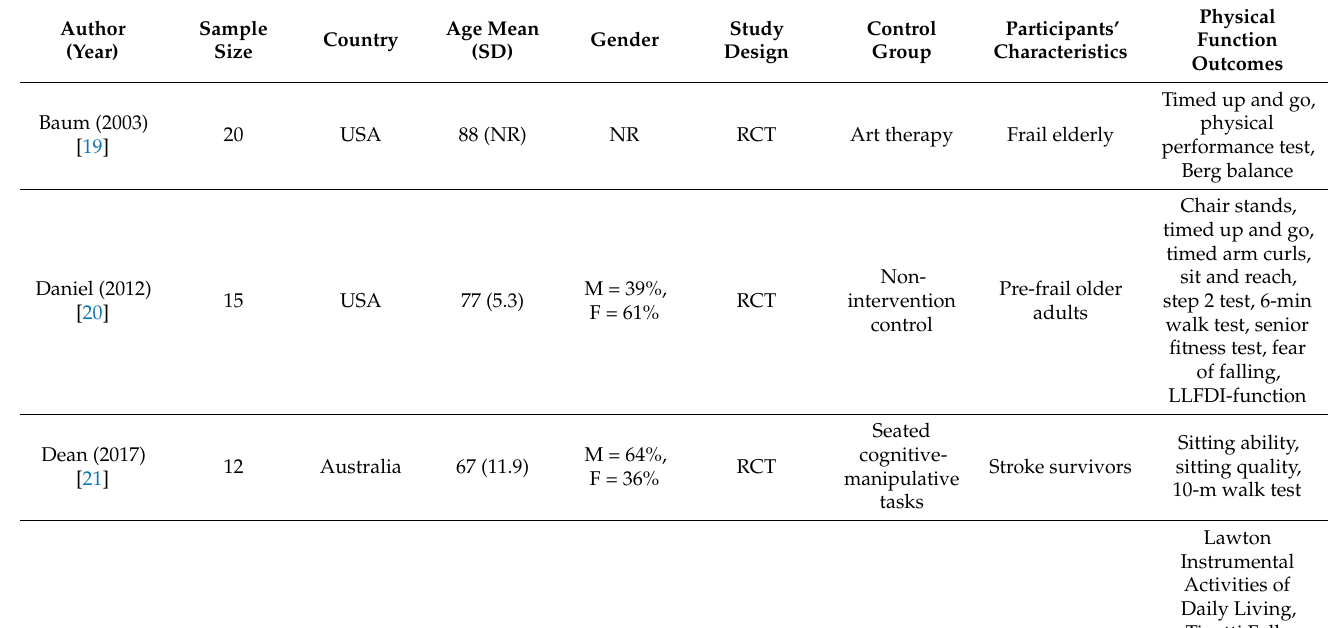
Table 1. Characteristics of Included